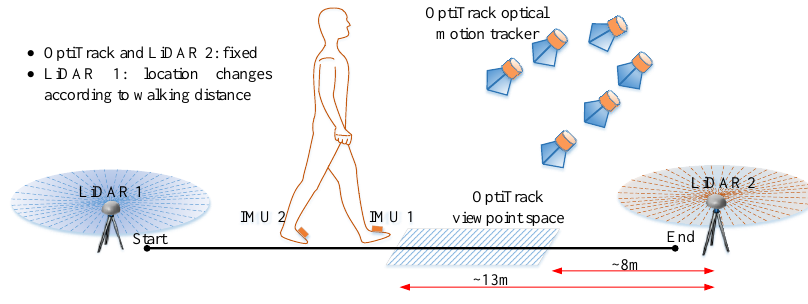
Figure 8. The configuration of the 20 m and 50 m walking distance experiment.